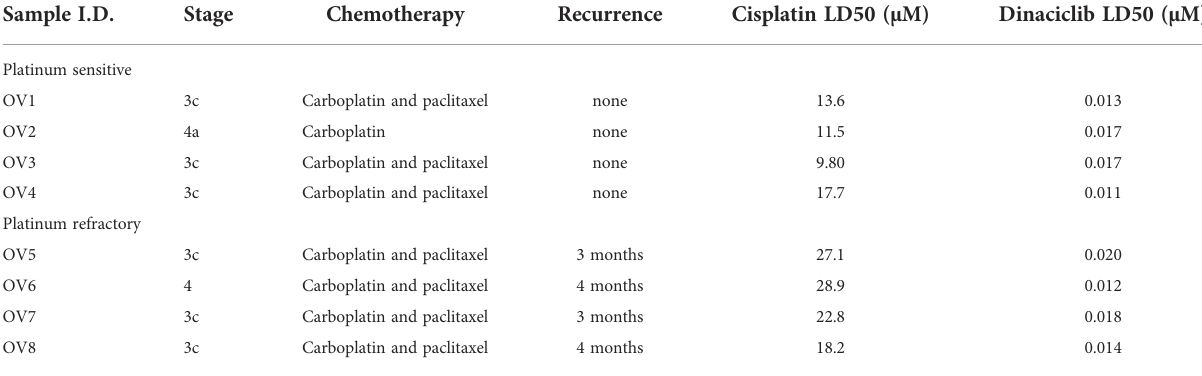
TABLE 1 Cisplatin and Dinaciclib LD50s in platinum sensitive and platinum resistant primary cells. Sample